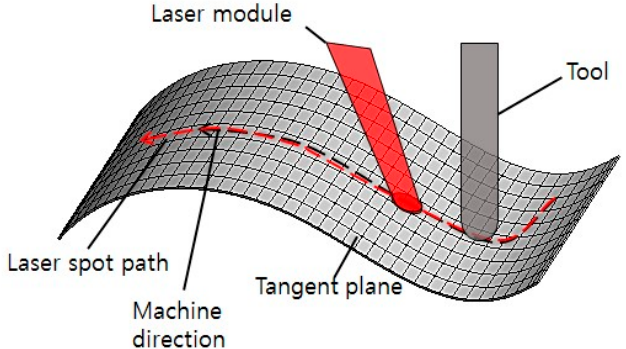
Figure 1. Schematic diagram of the curved shape machining using laser assisted milling.